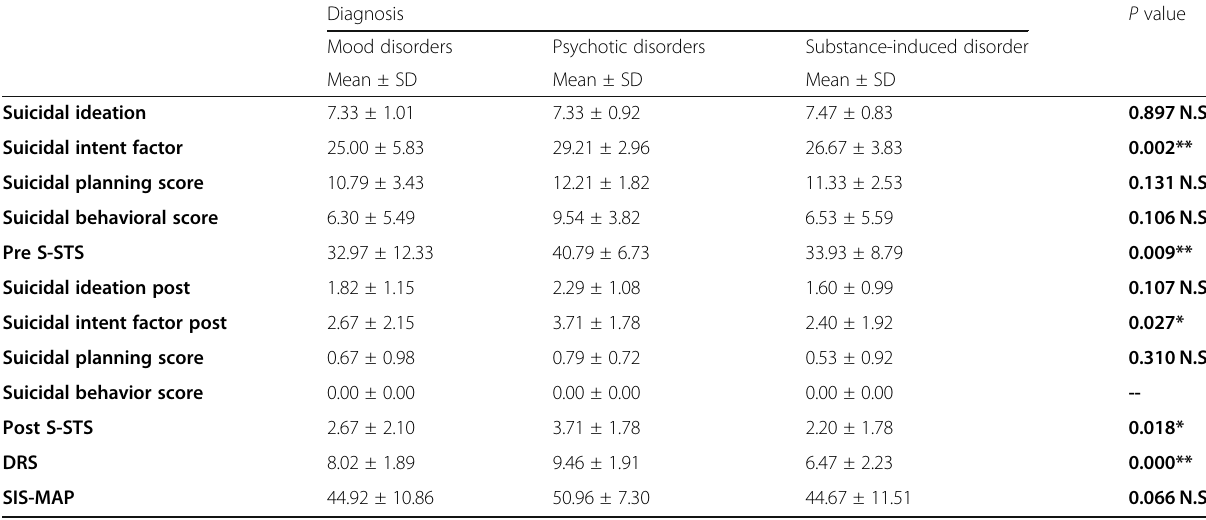
Table 5 Severity of suicidal behavior in different diagnoses in the studied